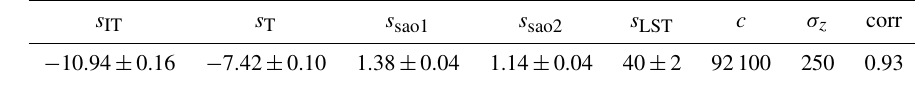
Table 2. SABER OH-VER-weighted altitude fit coefficients and diagnostics of Eq. (3). Resulting altitude in meters for vertically integrated